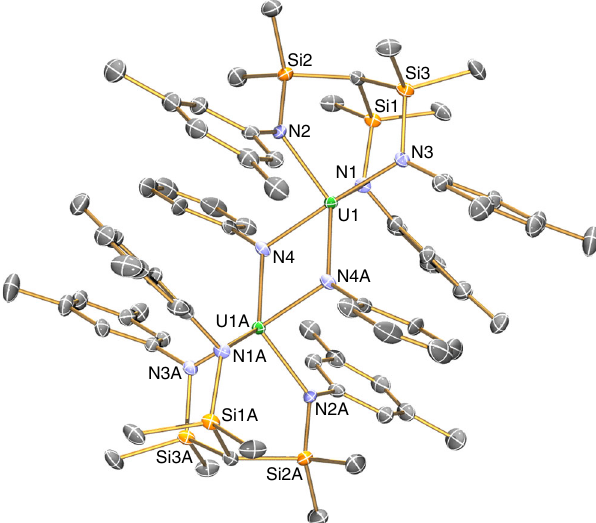
Fig. 5 Molecular structure of [{U(Ts Xy )( μ – NPh)} 2 ] ( 3 ) at 90 K with 40% probability ellipsoids. Hydrogen atoms and minor disorder components are omitted for clarity. 3 -D 10 is isostructural to 3 . Selected distances: 3